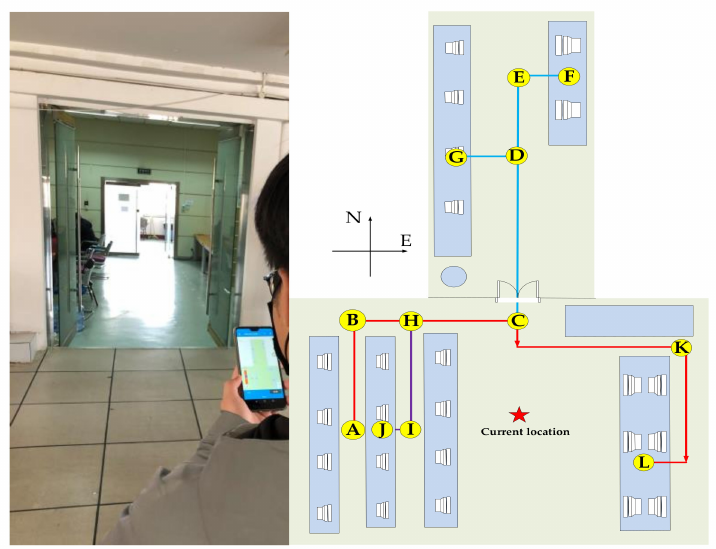
Figure 11. Small scale indoor test